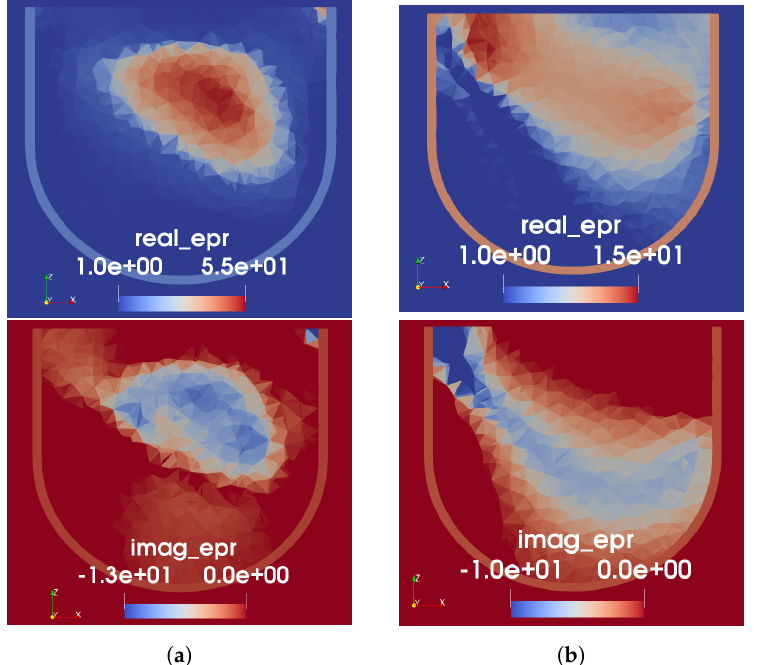
Figure 9. FEM-CSI reconstructions for Phantom 2. ( a ) Initial guess from tissue-range mapping. ( b ) Perfect prior of skin and fat only (no